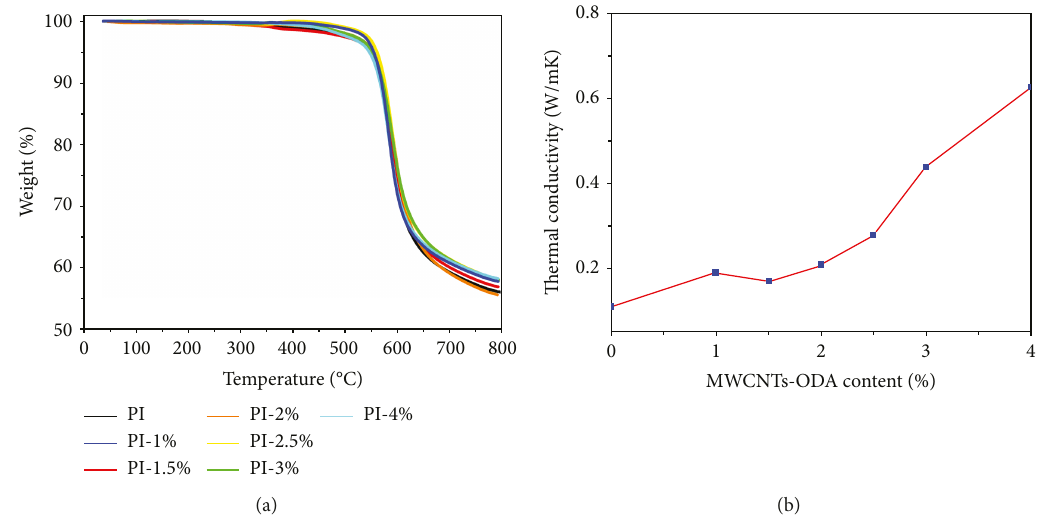
Figure 5: (a) TGA and (b) thermal conductivity curves of pure PI and MWCNTs-ODA/PI composite fi lms. Table 1: Thermal properties of pure PI and MWCNTs-ODA/PI composite fi lms. Sample